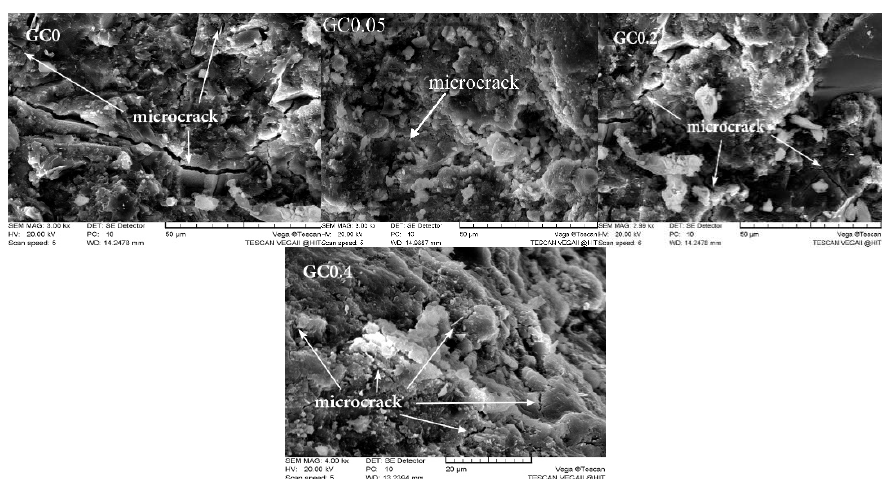
Figure 4. SEM images of the specimens after 200 freeze-thaw tests.